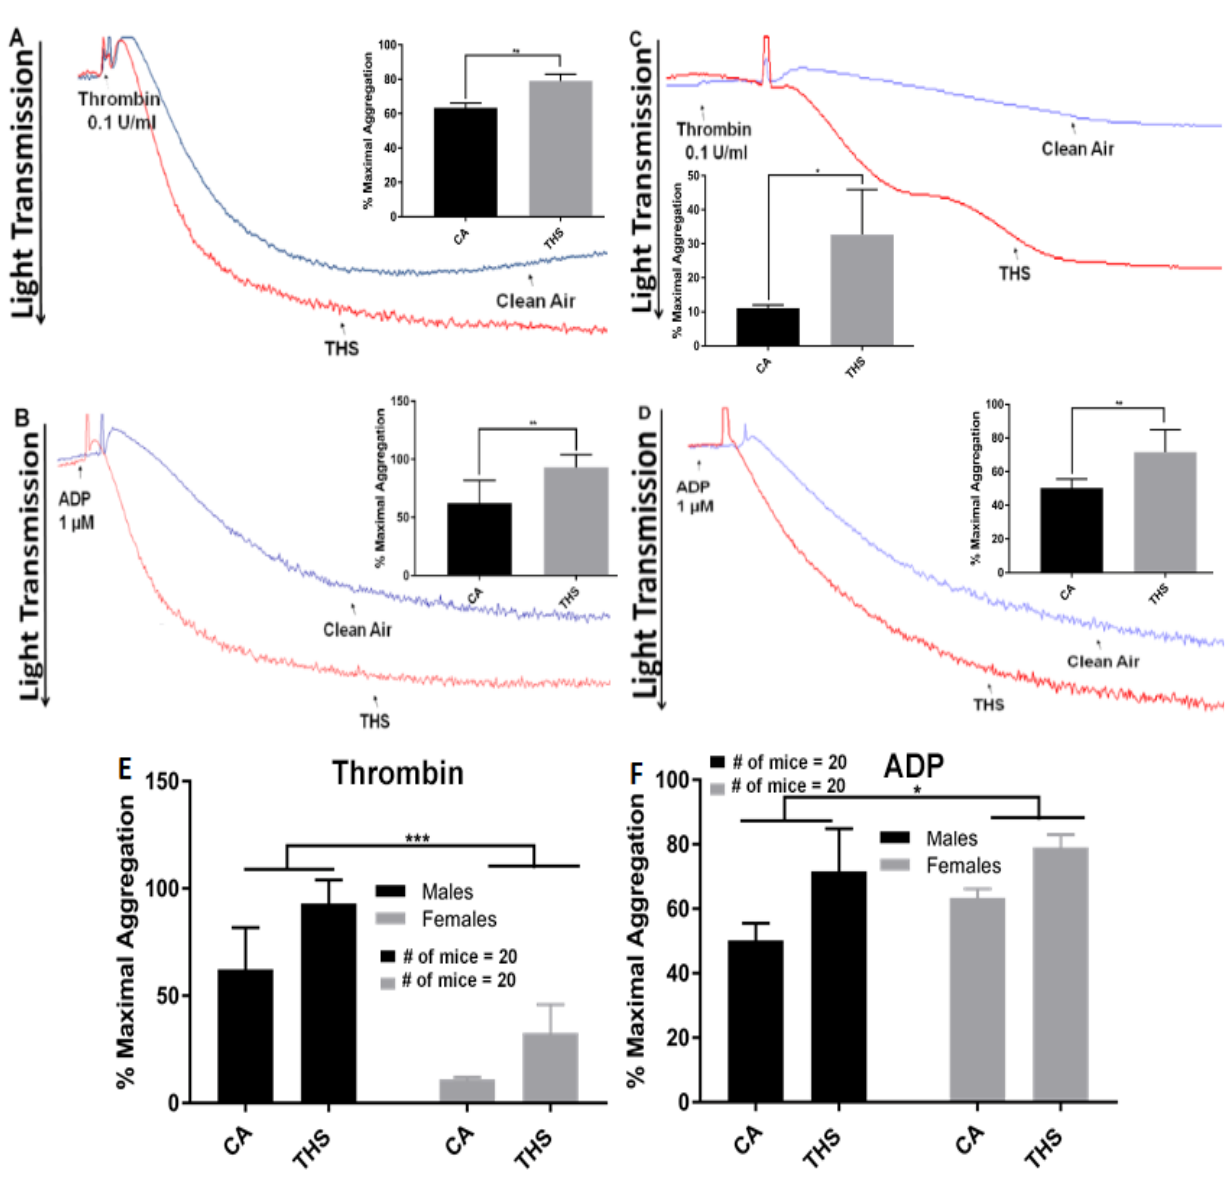
Figure 1. THS-exposed platelets show increased aggregation. THS-exposed and CA-exposed platelets from male ( A , B ) and female ( C , D ) mice were stimulated with either ( A , C ) thrombin (0.1 U/mL) or ( B , D ) ADP (1 μ M). Intersex differences for thrombin are shown in ( E ) whereas those for ADP are shown in ( F ). Each experiment was repeated four times with blood pooled from at least five THS-exposed and CA-exposed mice (* p < 0.05; ** p < 0.01; *** p < 0.001).